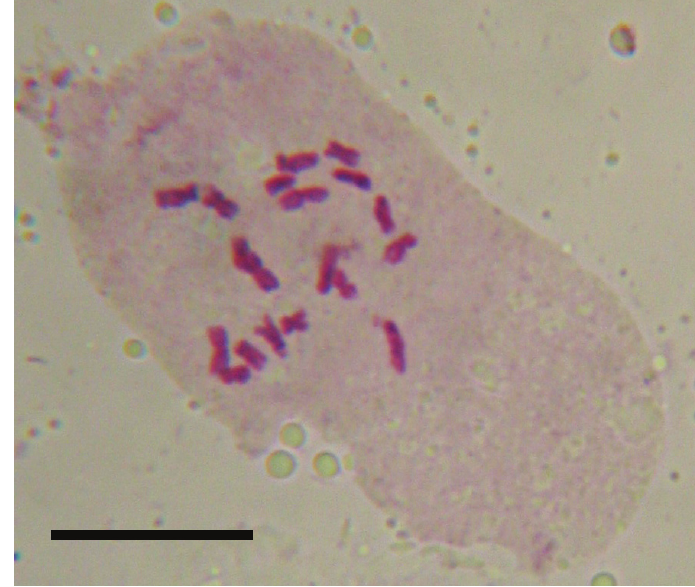
Figure 2. Centaurea calabra G.Caruso, S.A.Giardina, Raimondo & Spadaro, 2 n = 18 + 1B. Scale bar: 10